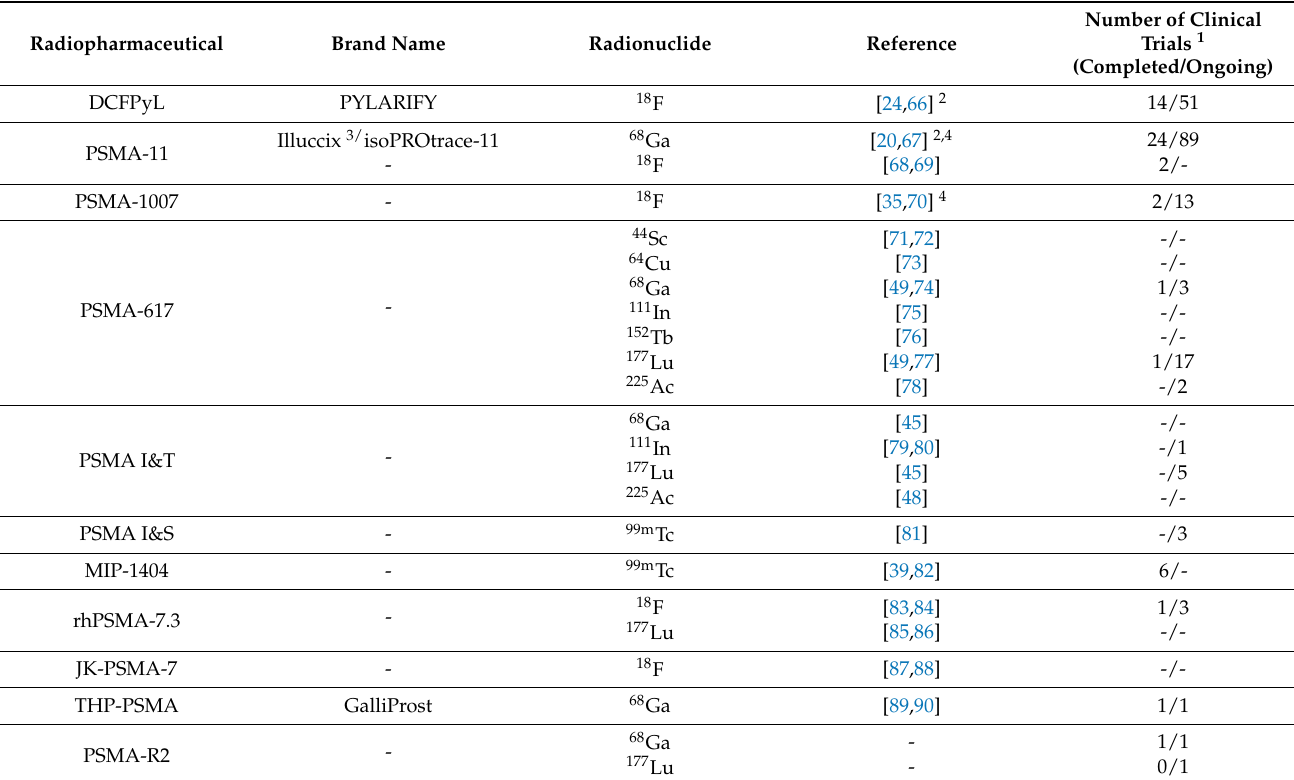
Table 1. PSMA-targeting radiopharmaceuticals marketed, under clinical investigation or in a clinical setting.